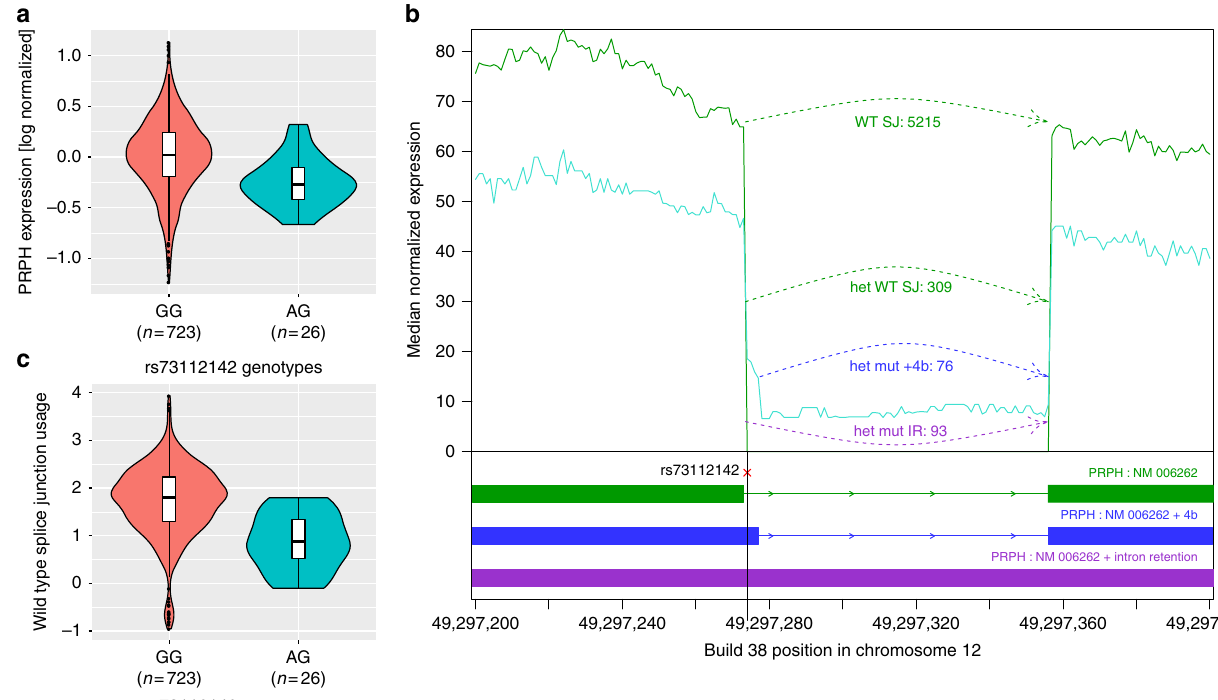
Fig. 4 Expression levels of PRPH by genotype. a Expression levels of PRPH mRNA from adipose samples ( N = 749). The violin plot represents density of expression estimates (log-normalized and adjusted for covariates), strati fi ed by rs73112142 genotypes (Effect = − 22.7% (95% CI: − 33.0 to − 10.9%), P = 4.0 × 10 − 4 ). The bottom and top of each box represent the fi rst and third quantiles, the line inside the box is the median, and whiskers represent the ±1.5 times the interquartile range. The fi lled circles correspond to expression values representing outliers that lie beyond the extremes of the whiskers. b RNA-seq coverage over the PRPH splice junction (SJ) site. The splice-donor variant, rs73112142, is on the black vertical line. Y -axis: median normalized expression in non-carriers (green, N = 723) compared to heterozygotes (turquoise, N = 26). Shown are fragment counts per allele (allele expression inferred): Normally spliced fragments in green for non-carriers (WT SJ; 5215 fragments) and heterozygous carriers (het WT SJ; 309 fragments), fragments with A-allele and 4 bp addition in blue (het mut + 4 bp; 76 fragments), fragments with A-allele and intron read-through in purple (het mut IR, 93 fragments). c PRPH wild-type splice junction (SJ) usage. Y -axis: SJ counts normalized for sequencing depth and log transformed. X -axis: Strati fi ed